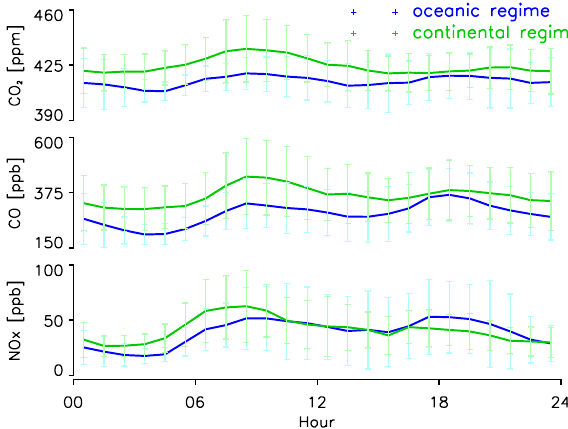
Fig. 4. Mean diurnal cycles of CO 2 , CO and NO x at the LHVP, Plateau of Saclay and Trainou sites for weekend and weekdays with the associated standard deviations. In the NO x plot for the LHVP, the mean diurnal cycle of vehicle flow during the weekdays for the year 2010 in Ile-de-France is added in orange (DiRIF).